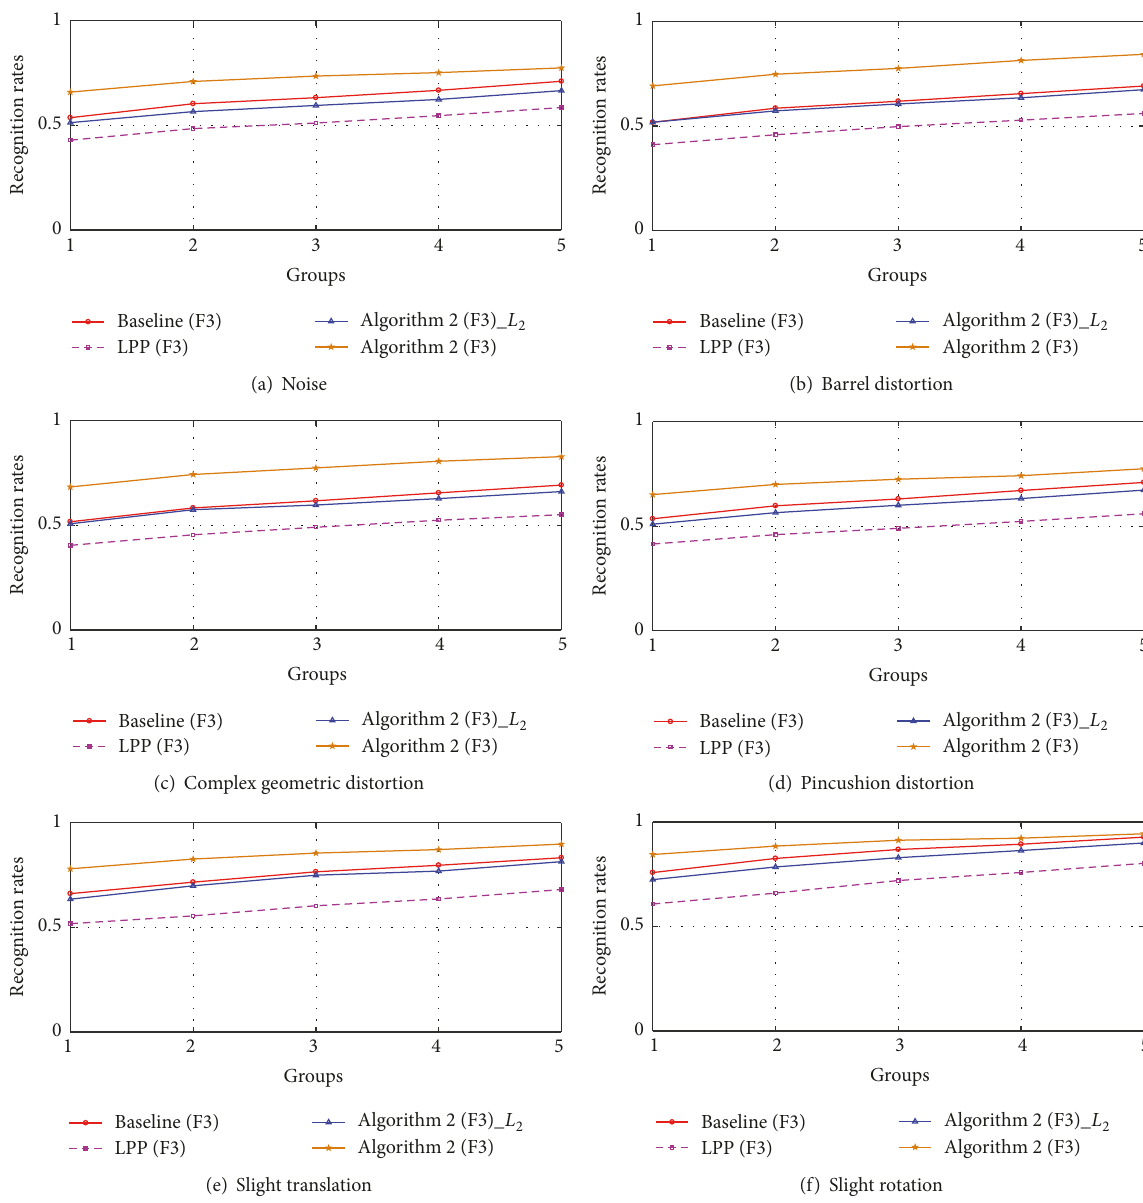
rotation Extended Yale B face databases are shown in Tables 22–27 and Figure 14 and the specific setting of the experiment is the same as that of Tables